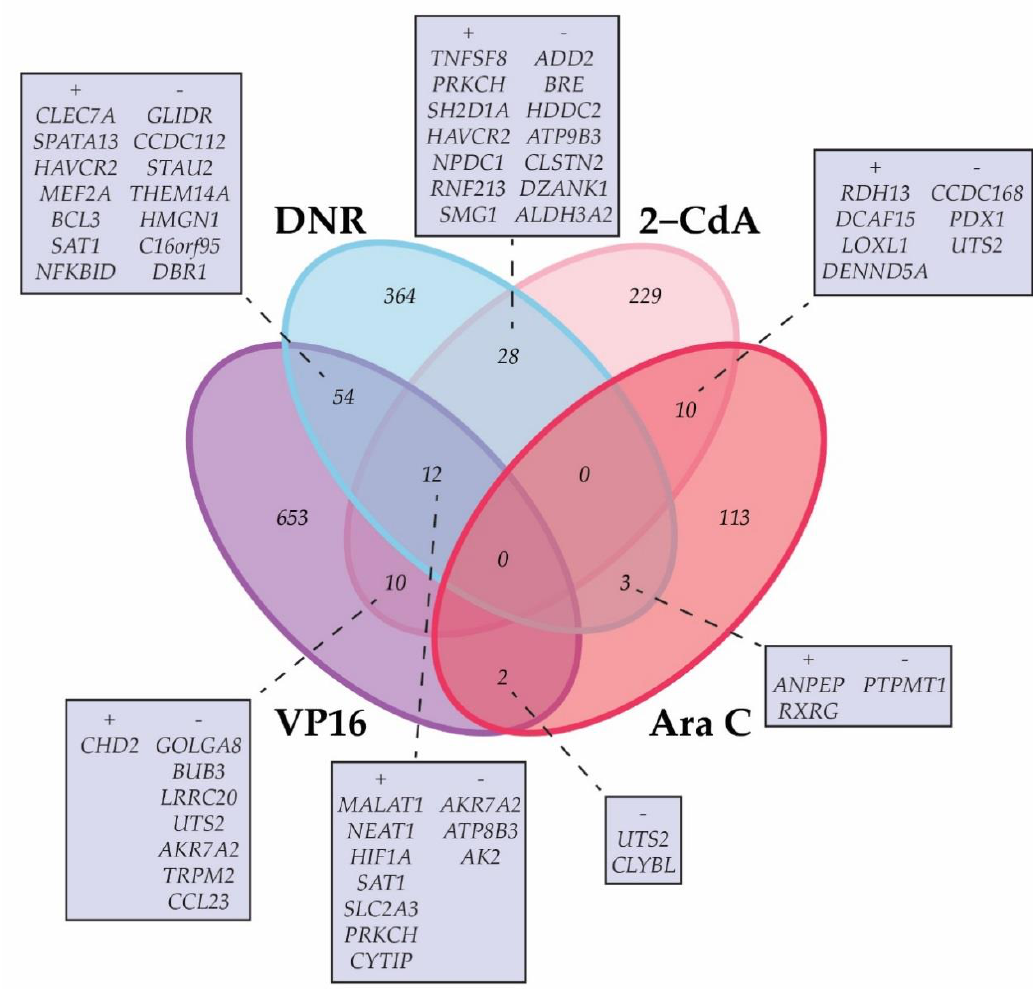
Figure 4. Schematic depiction of the number of genes that (inversely) correlate significantly (Spearman’s rank correlation p -value < 0.001) with ex vivo drug response in a single or two or more of the studied drugs (Ara C, VP16, DNR, 2-CdA). A + indicates a positive correlation with high LC 50 values, indicating relatively resistant samples. A − indicates a negative correlation with resistance. Overlapping genes are shown, ranked according to the Spearman’s rank correlation coefficient. A maximum of 14 genes are shown. A complete overview of overlapping genes is given in Supplementary Table S3.